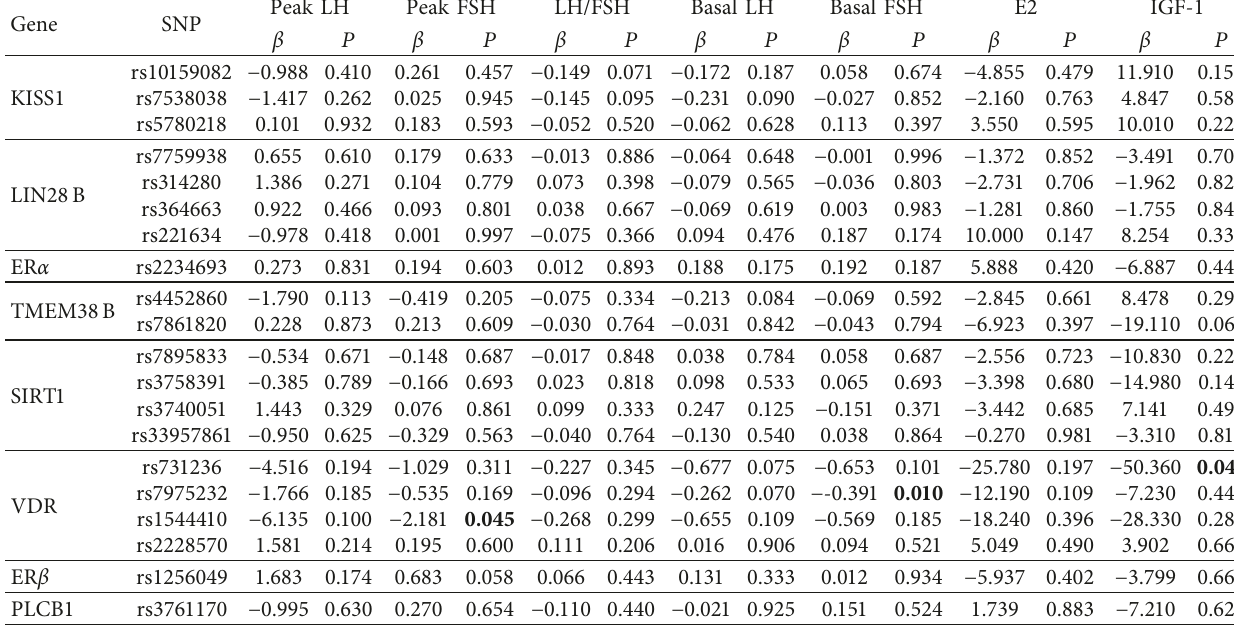
SNP: single nucleotide polymorphisms; LH: luteinizing hormone; FSH: follicle-stimulating hormone; E2: estradiol; IGF-1: insulin-1ike growth factor. Linear regression under the additive model was used to assess the associations between SNPs and peak LH, peak FSH, peak LH/FSH ratio, basal LH, basal FSH, E2, and IGF-1, adjusting for age and body mass index in CPP groups. Significant P values ( < 0.05) are highlighted in